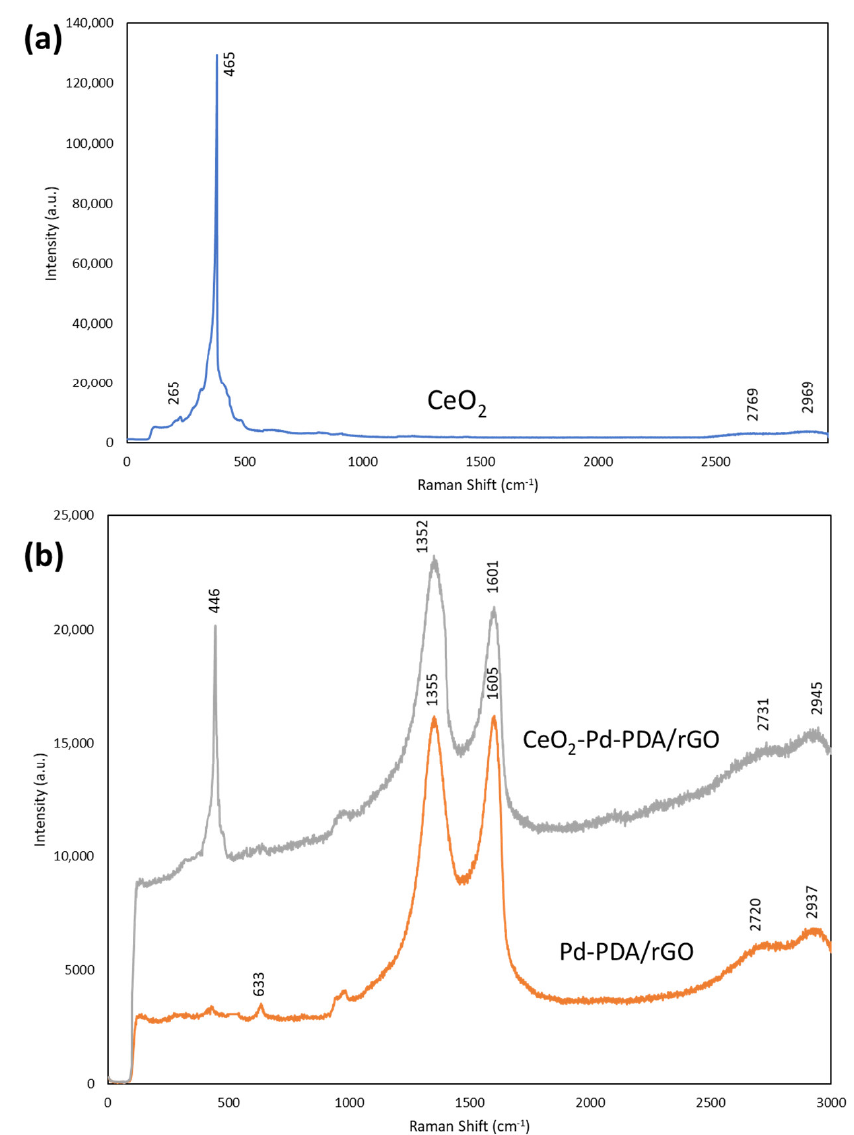
Figure 5. The Raman spectra of the ceria, ( a ) CeO 2 , and ( b ) Pd-PDA/rGO, and CeO 2 -Pd-PDA/rGO nanocomposite.